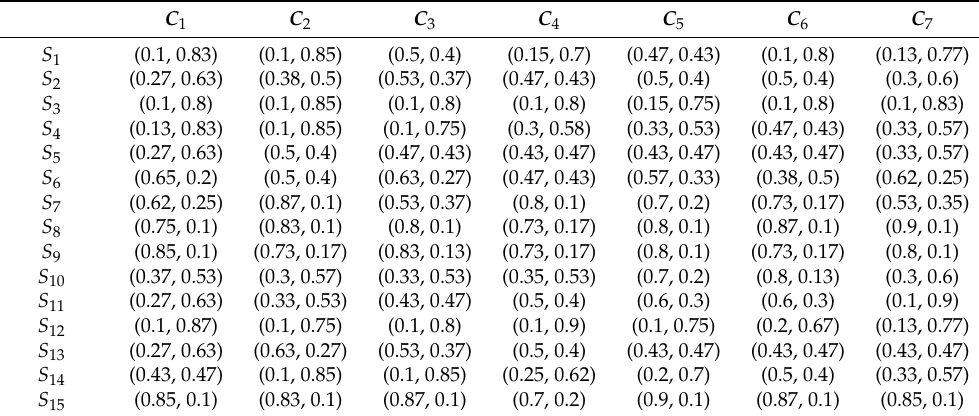
Table 6. The elements of the normalized